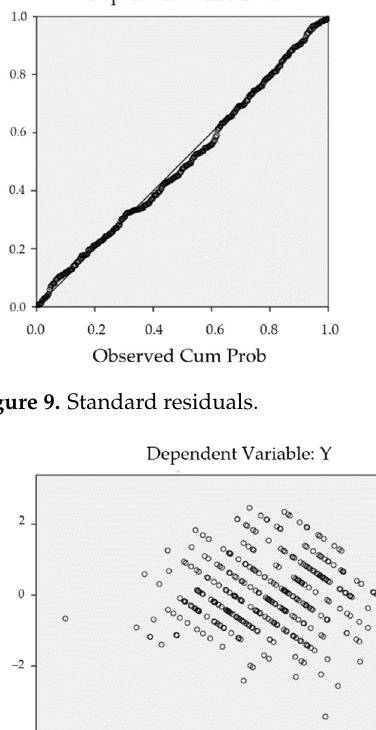
Figure 8. Histogram.